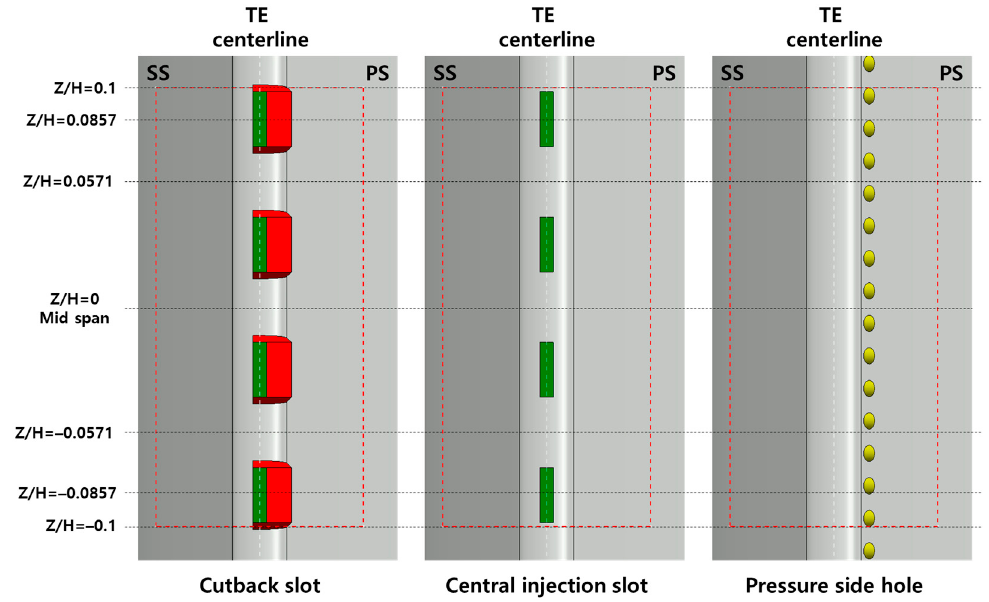
Figure 5. Measurement region of the total pressure loss (rear